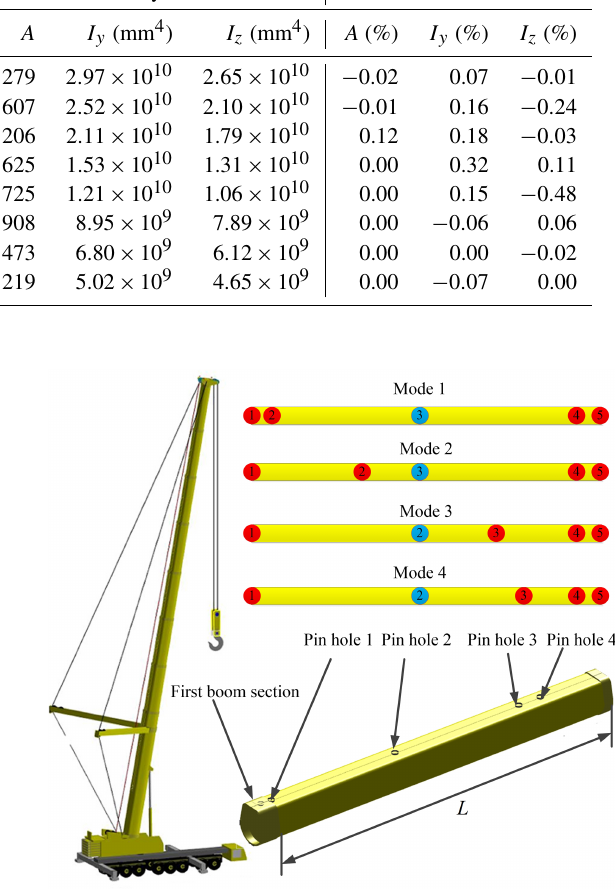
Figure 11. Telescopic boom combination modes.